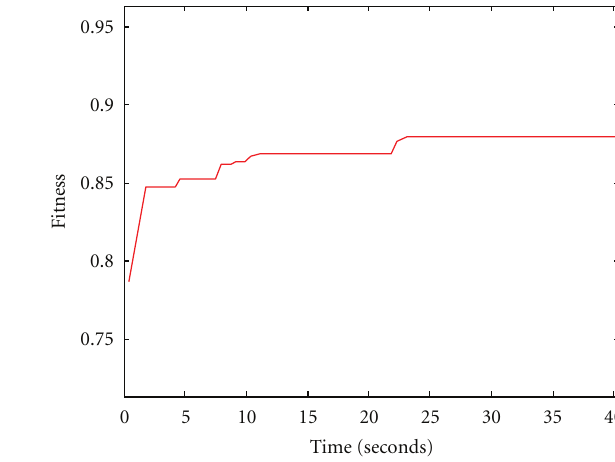
Figure 22: GA fitness